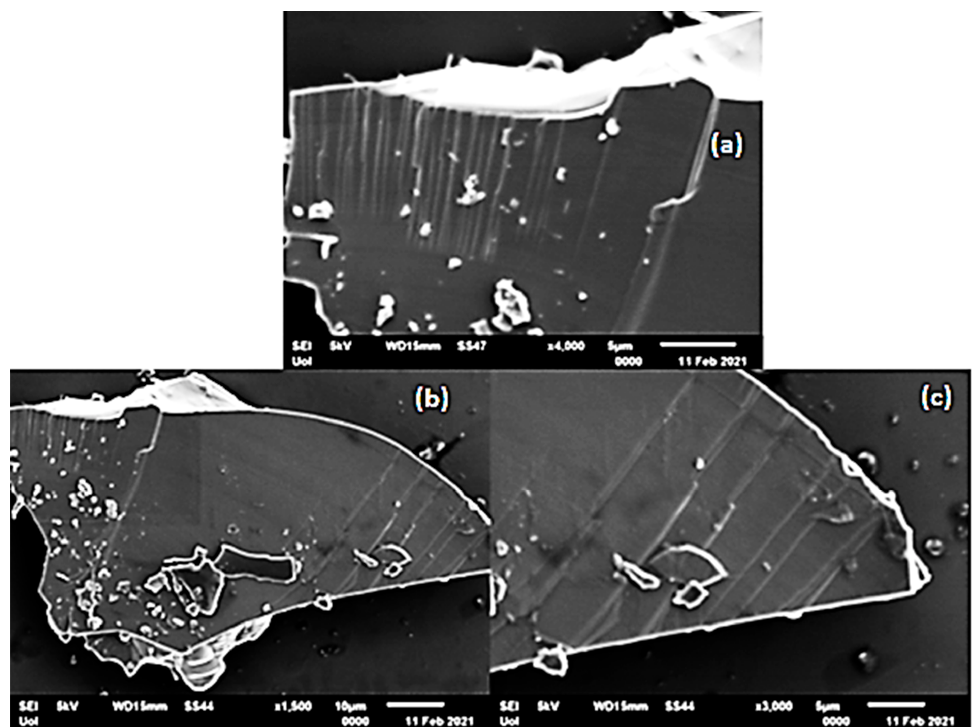
Figure 5. SEM images of the PC sample. ( a ) Magnification ×4000, scale 5 μ m, ( b ) magnification ×1500, scale 10 μ m, ( c ) magnification ×3000, scale 5 μ m.